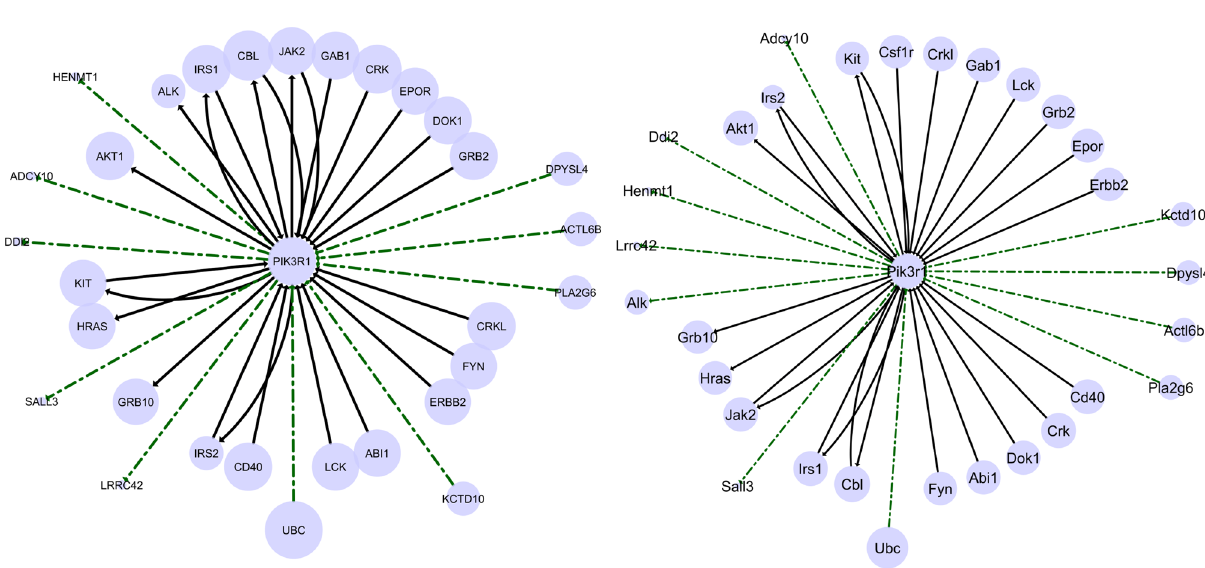
Figure 9. The subnetwork identified for the human hub gene PIK3R1 (on the left) and the mouse hub gene Pik3r1 (on the right). The size of the circle of a gene represents the number of genes regulated by such a gene. Known interactions (from BioGRID) are represented as black lines, while interactions predicted by our system are represented as green dotted